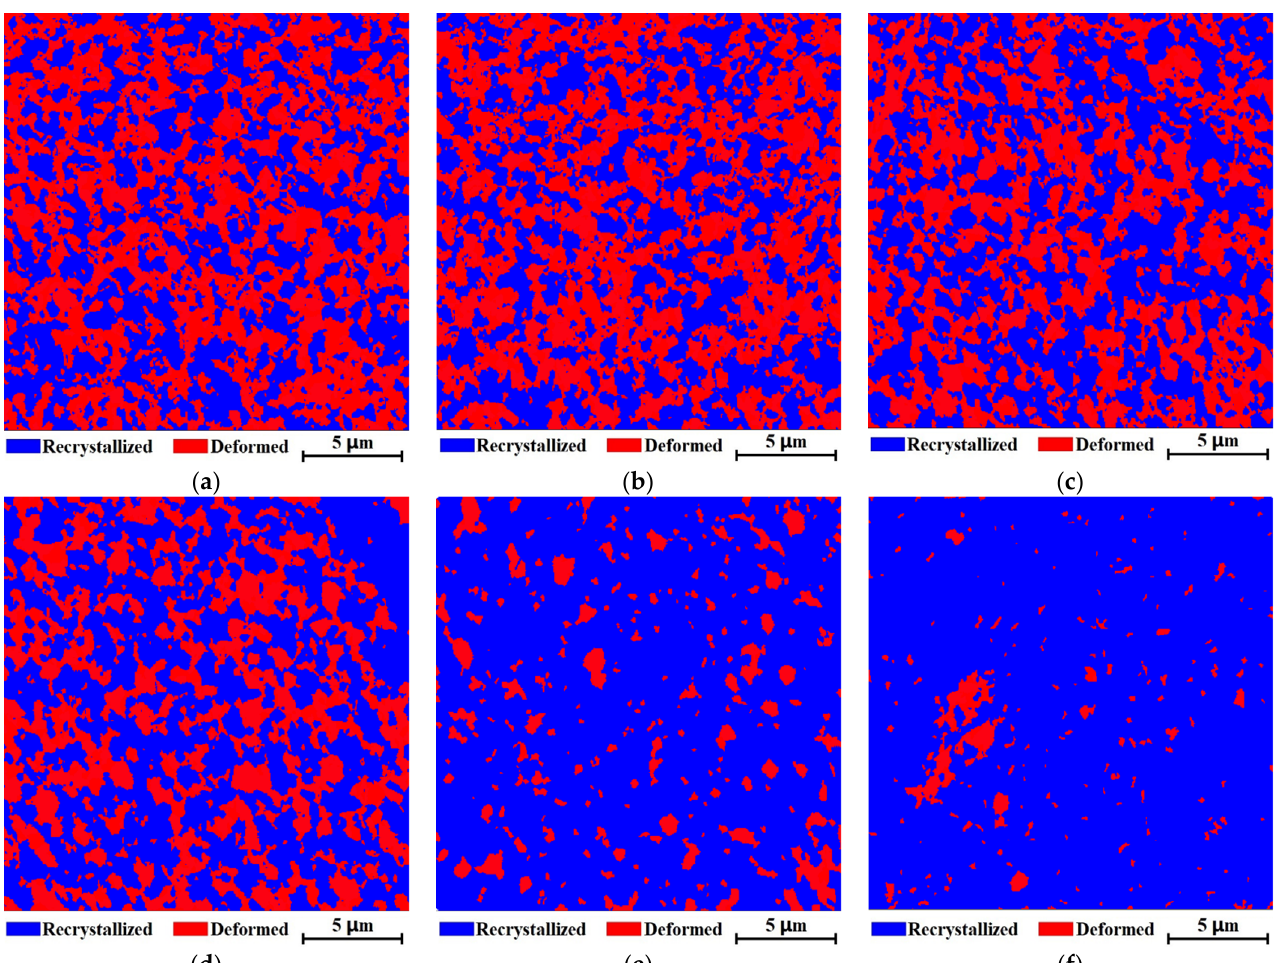
Figure 7. Deformation fraction maps of samples prepared by ( a ) HOP at 550 °C, ( b ) HOP at 600 °C, ( c ) HOP at 650 °C, ( d ) HOP at 700 °C, ( e ) HP at 550 °C, and ( f ) HP at 700 °C, respectively.